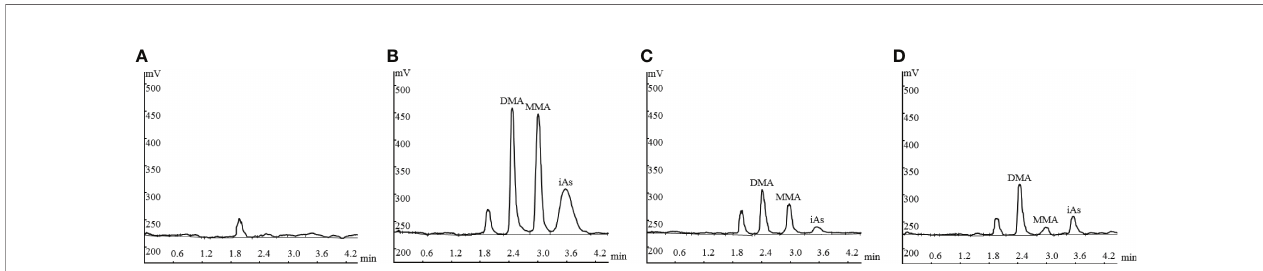
FIGURE 1 | Representative HPLC-HG-AFS chromatograms: drug-free plasma (A) ; drug-free plasma spiked with standards of arsenic species (B) ; plasma sample from a patient with APL (C) , and amniotic fl uid sample from a patient with APL (D) . HPLC – HG – AFS: high-performance liquid chromatography – hydride generation –